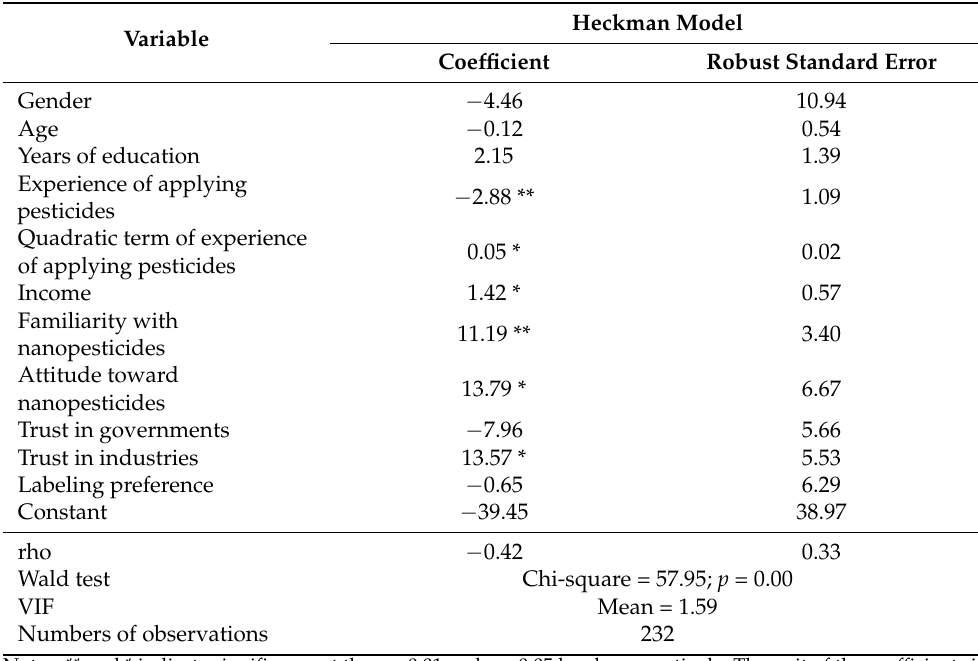
Table A1. Heckman model for testing sample selection